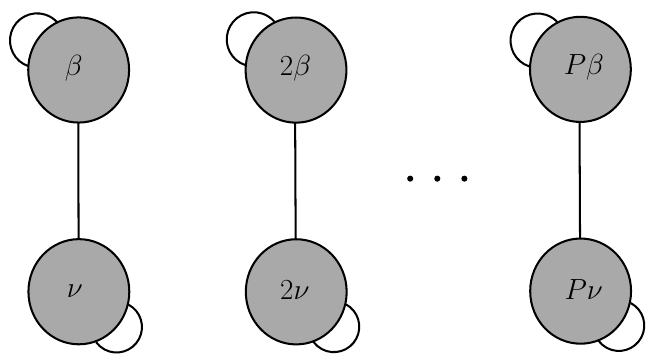
Figure 11 . Quiver mechanics associated to the backgrounds obtained from eqs. (3.19)–(3.20).